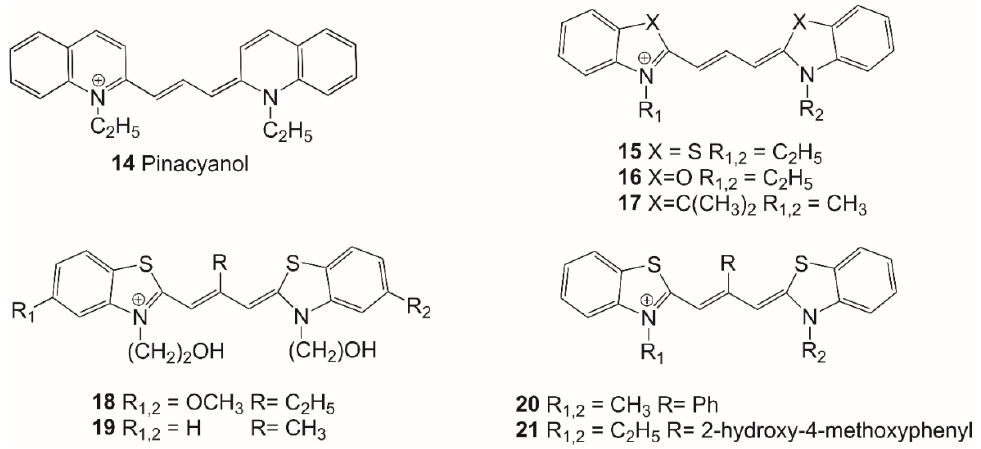
Figure 6. Structures of cationic cyanines 14 – 21 .